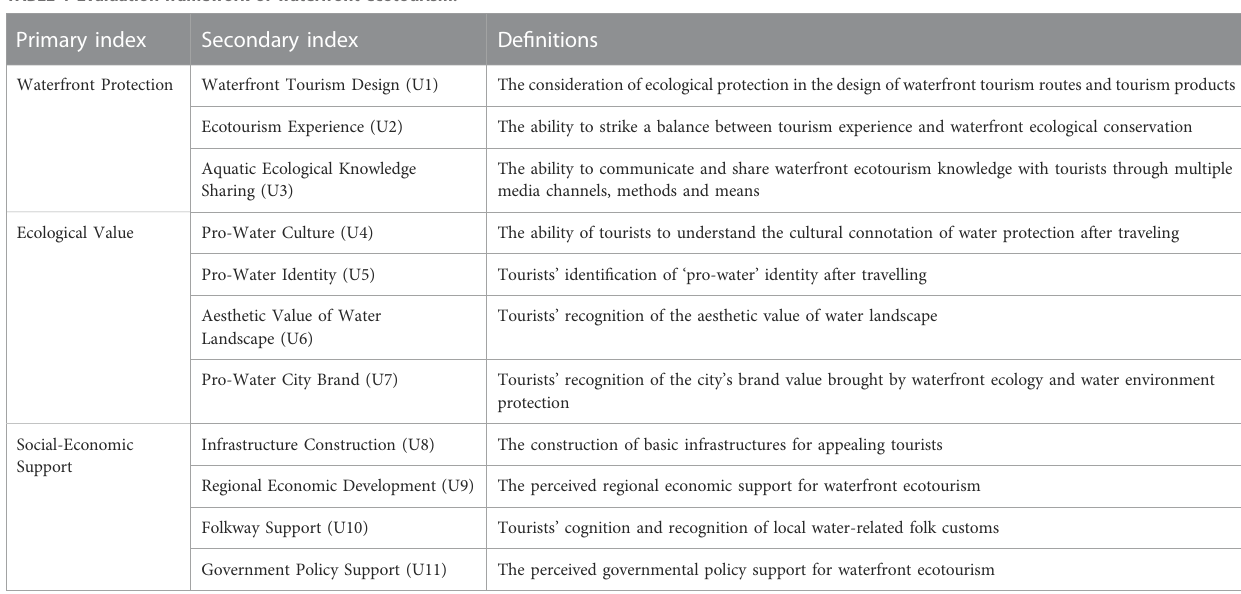
TABLE 1 Evaluation framework of waterfront